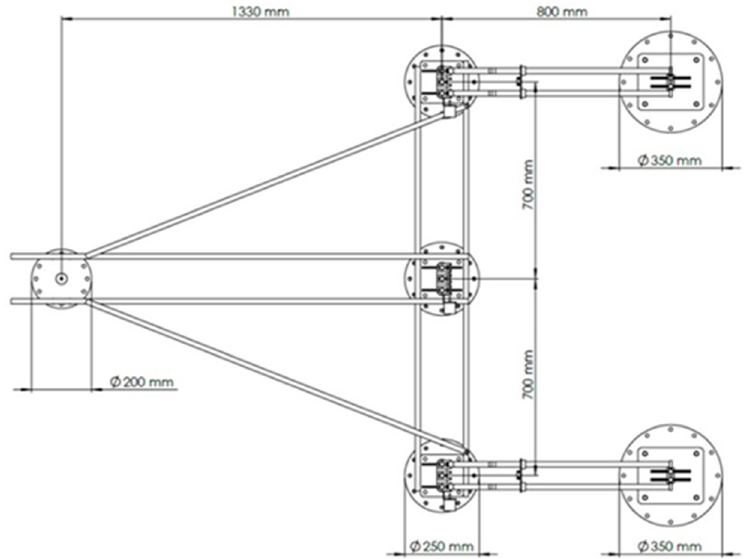
Figure 3. Plan dimensions of physical model.